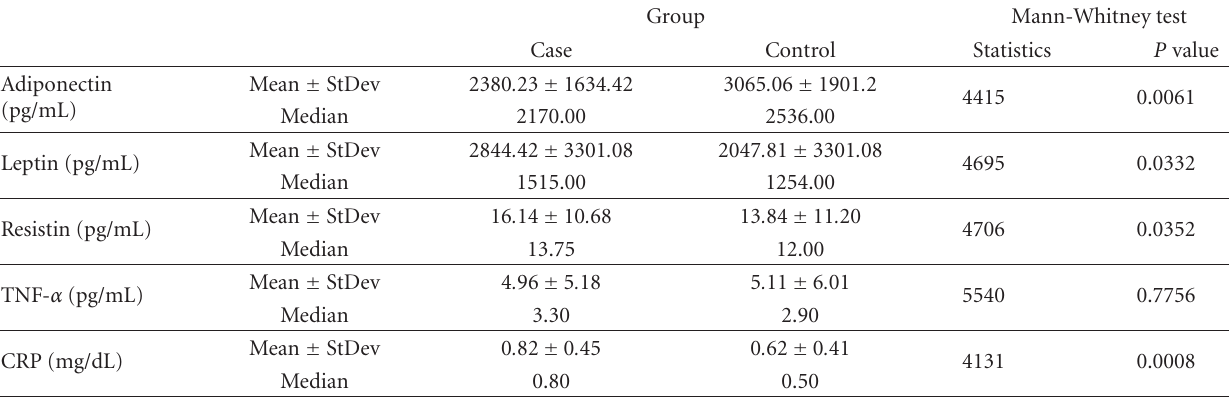
Table 3: Serum concentrations of the studied parameters in the di ff erent studied